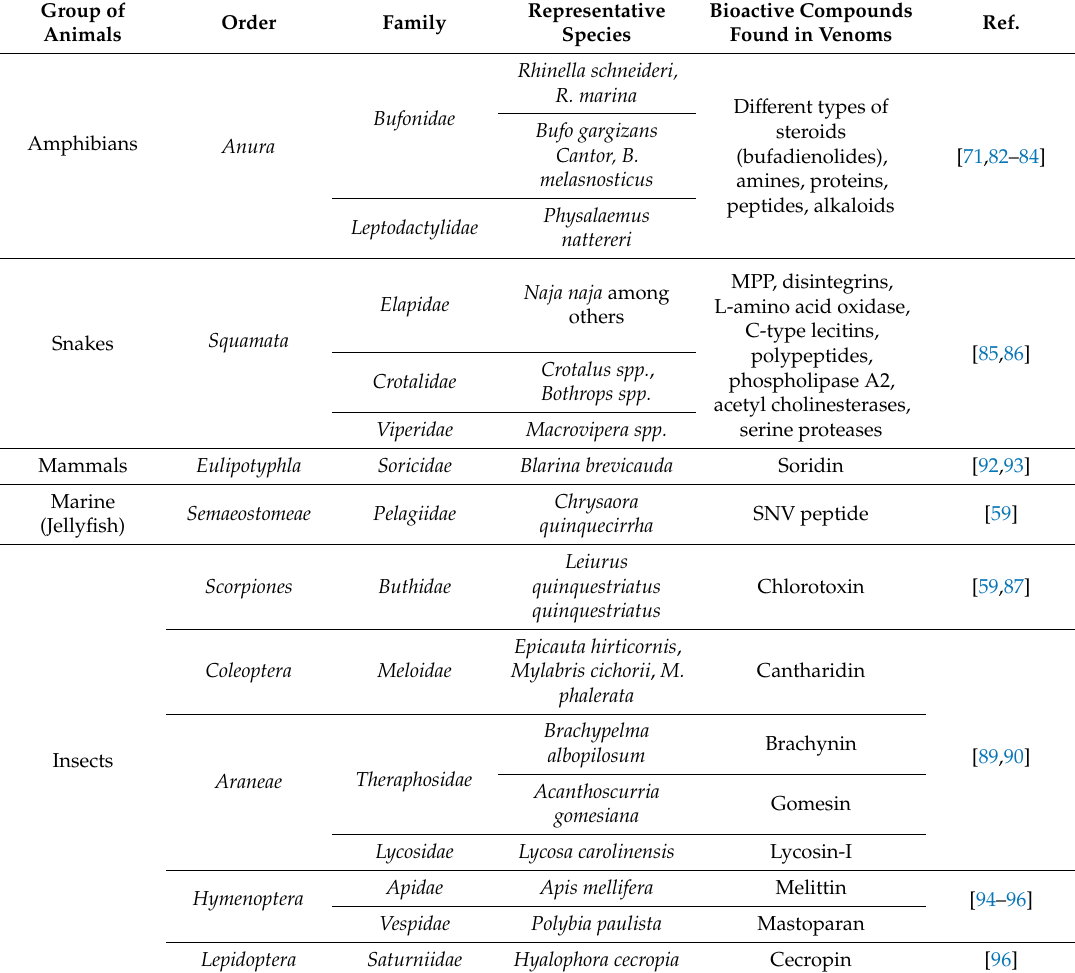
Table 2. Summary of mentioned examples of animal venoms. Abbreviation: Ref,